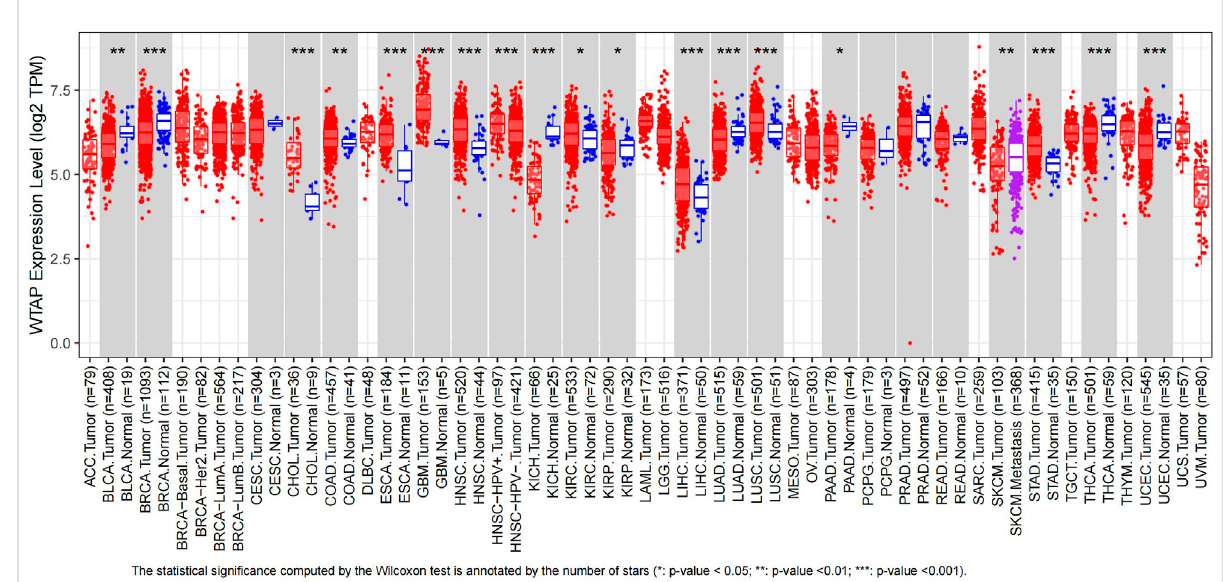
FIGURE 1 Human WTAP expression levels in different types of cancer from TCGA data in TIMER. Gray rectangles represent cancer types. Red patterns standfortumorsampleswhilebluepatternsstandfornormalsamples.Purplepatternrepresentsmetastasissamples.Somecancertypesareshortof normalsamplesandcorresponding p valuecannotbecalculated.* p < 0.05,** p < 0.01,*** p < 0.001.(ACC,adrenocorticalcarcinoma;BLCA,bladder urothelial carcinoma; BRCA, breast invasive carcinoma; CESC, cervical squamous cell carcinoma and endocervical adenocarcinoma; CHOL, cholangiocarcinoma; COAD, colon adenocarcinoma; DLBC, lymphoid neoplasm diffuse large B-cell lymphoma; ESCA, esophageal carcinoma; GBM, glioblastoma multiforme; HNSC, head and neck squamous cell carcinoma; KICH, kidney chromophobe; KIRC, kidney renal clear cell carcinoma; KIRP, kidney renal papillary cell carcinoma; LAML, acute myeloid leukemia; LGG, brain lower grade glioma; LIHC, liver hepatocellular carcinoma; LUAD, lung adenocarcinoma; LUSC, lung squamous cell carcinoma; MESO, mesothelioma; OV, ovarian serous cystadenocarcinoma; PAAD, pancreatic adenocarcinoma; PCPG, pheochromocytoma and paraganglioma; PRAD, prostate adenocarcinoma; READ, rectum adenocarcinoma; SARC, sarcoma; SKCM, skin cutaneous melanoma; STAD, stomach adenocarcinoma; TGCT, testicular germ cell tumors; THCA, thyroid carcinoma; THYM, thymoma; UCEC, uterine corpus endometrial carcinoma; UCS, uterine carcinosarcoma; UVM, uveal